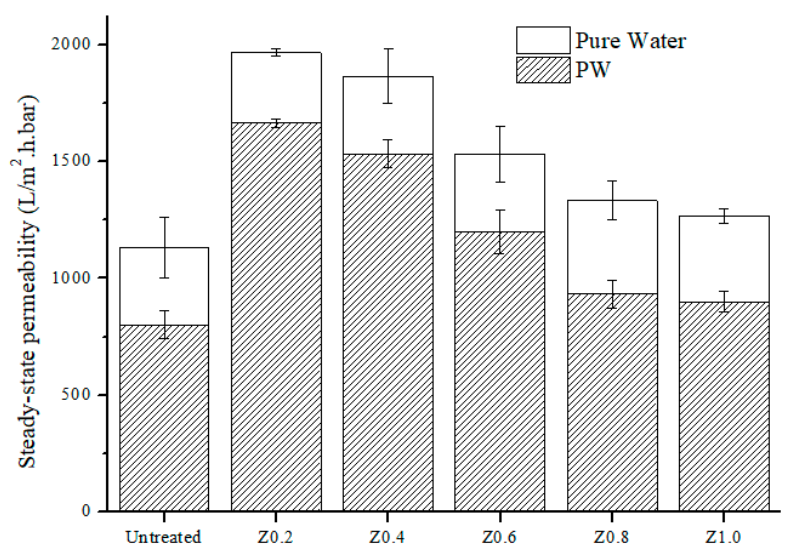
Figure 11. Steady-state pure water and PW permeability for untreated nylon 6,6 NFM and nylon 6,6/ZIF-8 NFM.